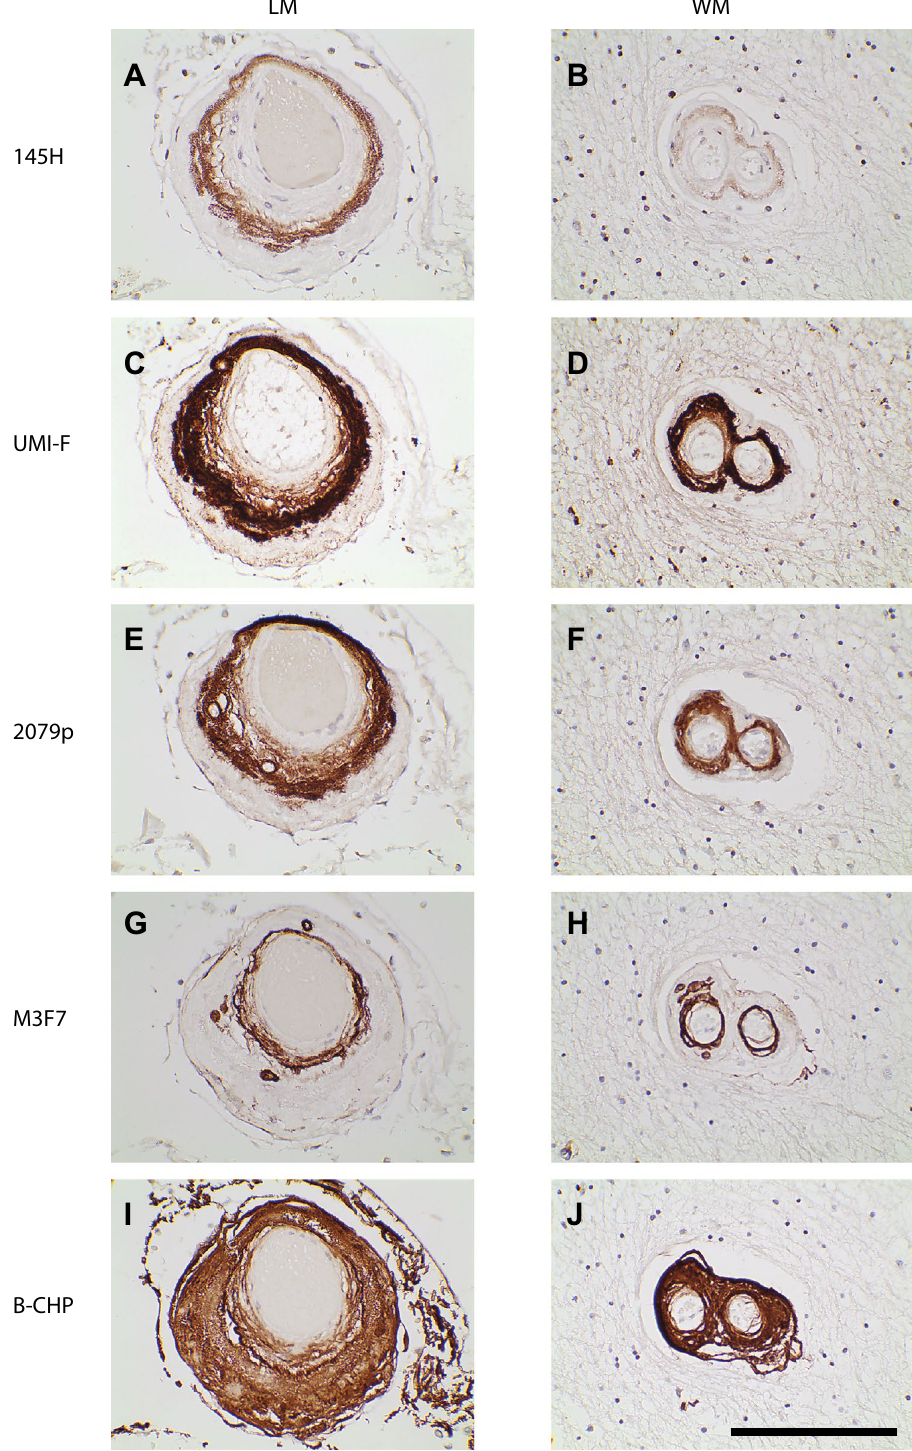
Figure 4. Localization of Asp121 cleavage with other NOTCH3 transformations and collagen. Serial sections from CADASIL brain show LM and WM brain regions stained with antibodies denoted. Consecutive 5 micron slices from the same block were stained with probes shown and representative images were captured. The LM and WM images are from the same slide. 145H recognizes the Asp121 neo-epitope (0.6 µg/ml), 2079 stains reduced NOTCH3 6 (1:500 dilution), UMI-F recognizes the Asp80 neo-epitope 7 (undiluted supernatant from transfected 293 cells), M3F7 recognizes type IV collagen (1:50 dilution), and B-CHP recognizes denatured collagen 21 (1:50 dilution). Scale bar represents 100 microns for all